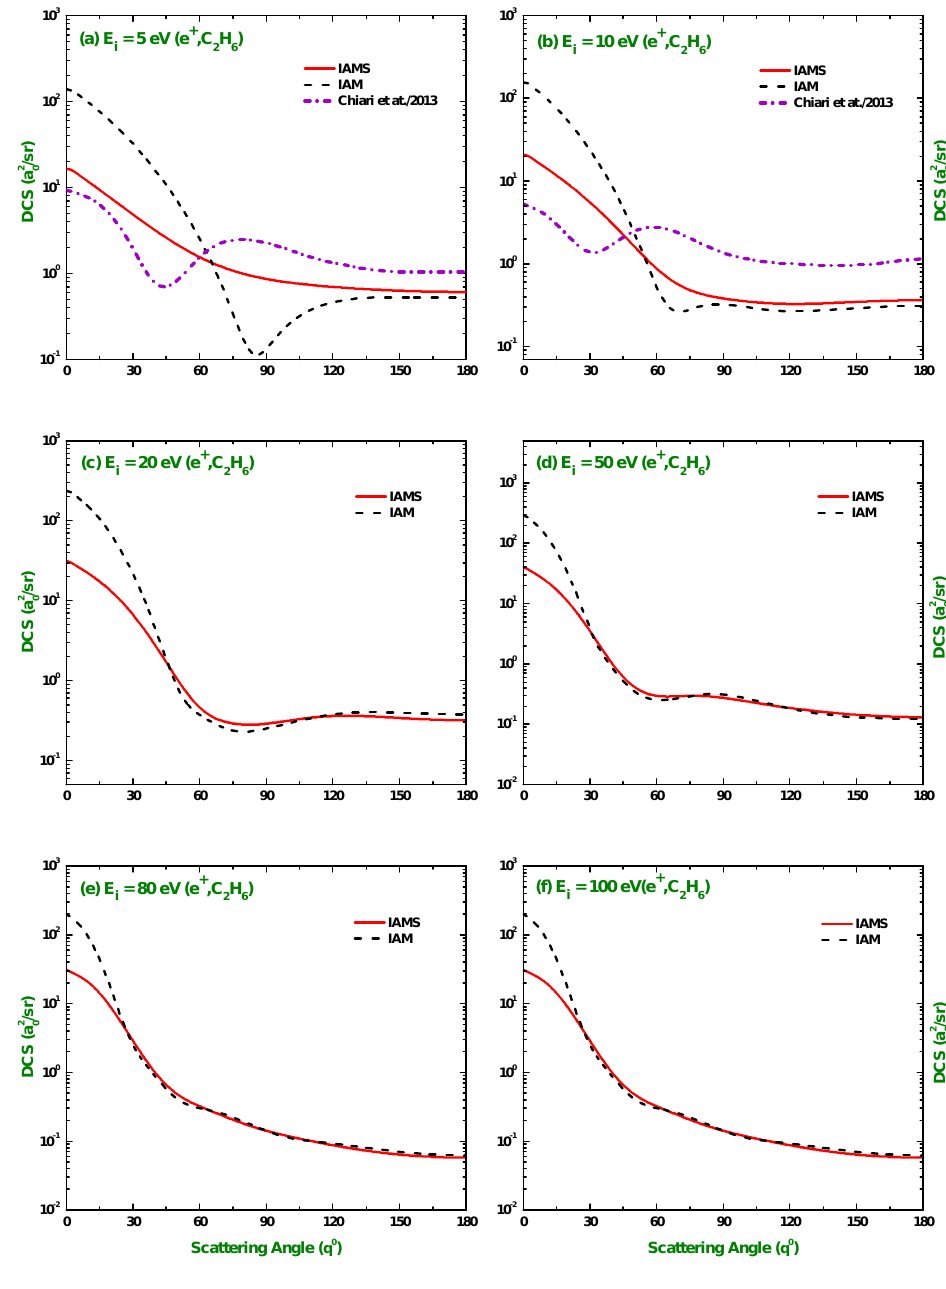
Figure 5. DCS ( a 2 / sr ) for the elastic scattering of positrons from C 2 H 6 at energies of 5, 10, 20, 50, 80, 0 and 100 eV. Theoretical works: IAM, IAMS, and Chiari et al.